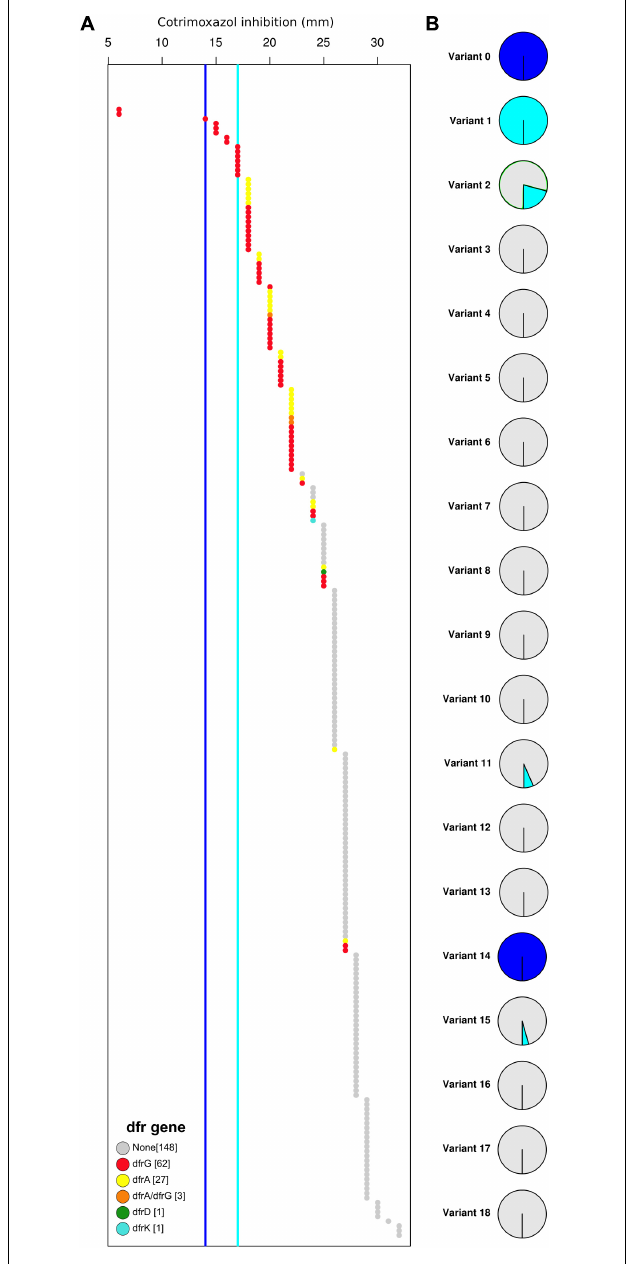
FIGURE 3 | High-level co-trimoxazole (SXT) resistance is the result of a DHPS mutation (F17L) and the acquisition of an extra-chromosomal dfr gene. (A) All strains are represented in an increasing order based on the zone of inhibition of co-trimoxazole (in mm). Color represent the extra-chromosomal DHFR variant ( dfr gene). Dark blue line indicates cut-off for SXT resistance, Light blue line indicates cut-off for SXT susceptibility. (B) The percentage of resistant (dark blue), intermediate (light blue), and sensitive (gray) strains are displayed as a pie-chart for each DHPS